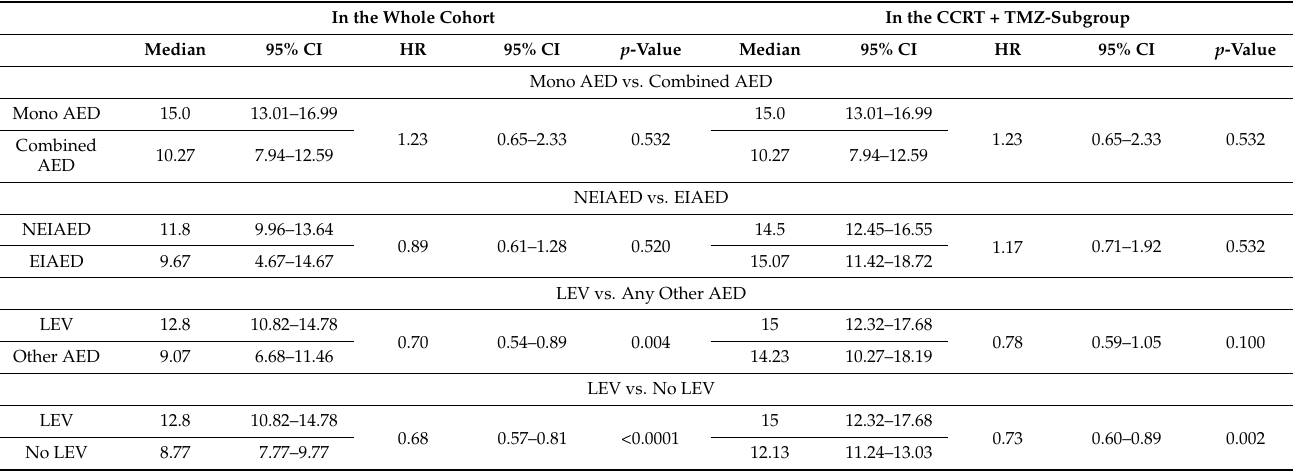
Table 1. OS values incl. HRs in different AED categories within the whole cohort and subgroup with adjuvant chemoradia- tion with TMZ (CCRT + TMZ-subgroup).